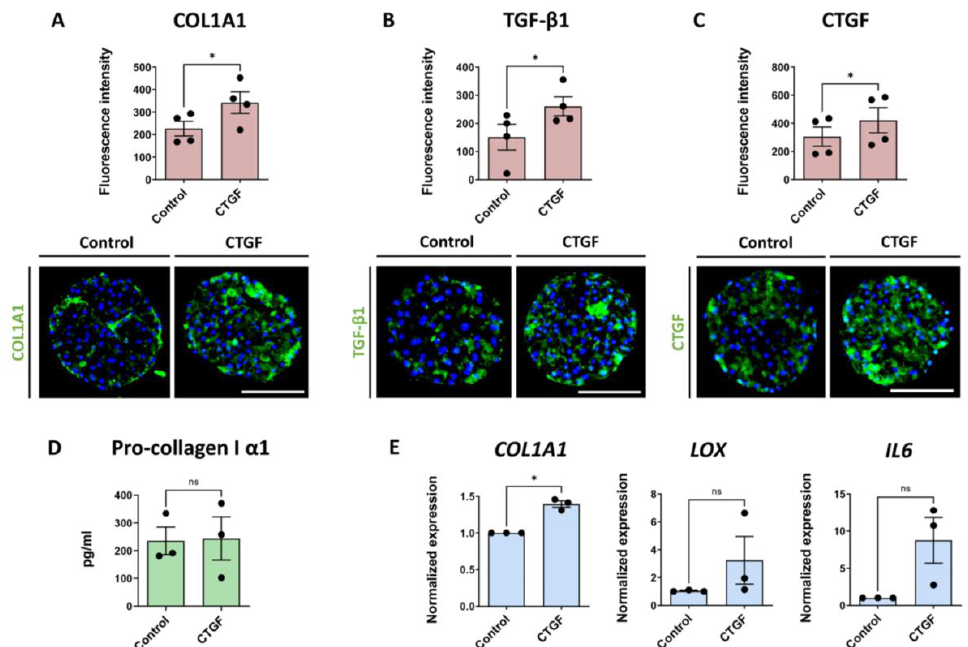
Figure 4. CTGF contributes to liver fibrosis in the 3D liver co-culture fibrosis model. Blue bars represent mRNA expression data. Red bars represent results of IHC analysis and green bars represent data based on ELISA analyses. ( A – C ) CTGF treatment significantly increased the production of COL1A1, TGF- β1 and CTGF, as revealed by IHC (n = 4); (3 experiments with PHH donor 1 and 1 experiment with PHH donor 2; NPC from donor 3 were used in all 4 experiments). ( D ) Pro-collagen I α 1 release was not affected by the CTGF treatment (n = 3) ( E ) COL1A1 , LOX and IL6 mRNA levels were increased after a 7-day CTGF treatment, although the changes in LOX and IL6 expression did not reach statistical significance (n = 3, 2 experiments with the PHH donor 1 and 1 experiment with PHH donor 2; NPC from donor 3 in all 3 experiments). Every dot represents data from 1 experiment. Every dot in the red bars represents an average of at least 10 analyzed sections of spheroids per experiment. The size of the spheroi ds is marked with a white scale bar of 100 μm. Data are shown as mean ± SEM. Statistical analysis — Student ’ s t -test; * p < 0.05; ns: not significant.